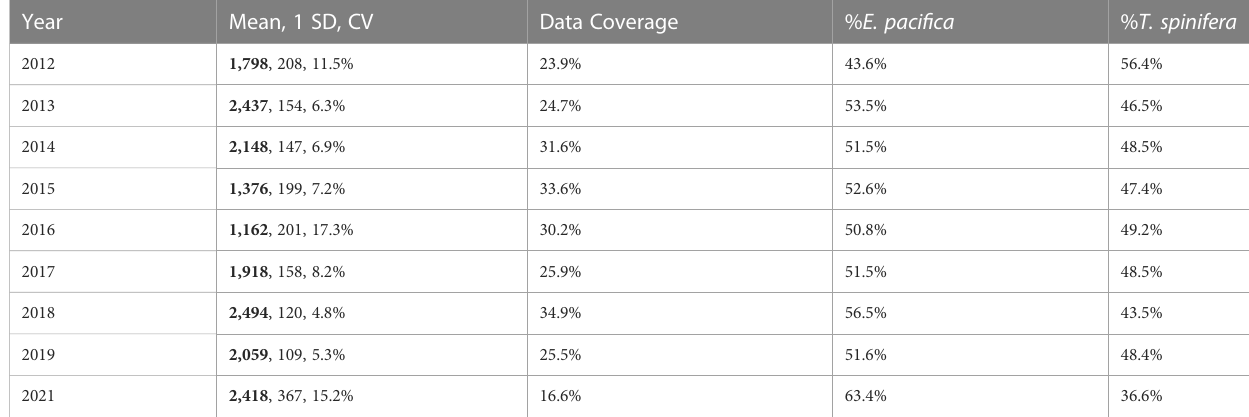
TABLE 3 Annual krill biomass (thousands of metric tons (kmt); bold), standard deviation (SD, kmt), coef fi cient of variation (CV), percent data coverage, and percent biomass of each species from the entire